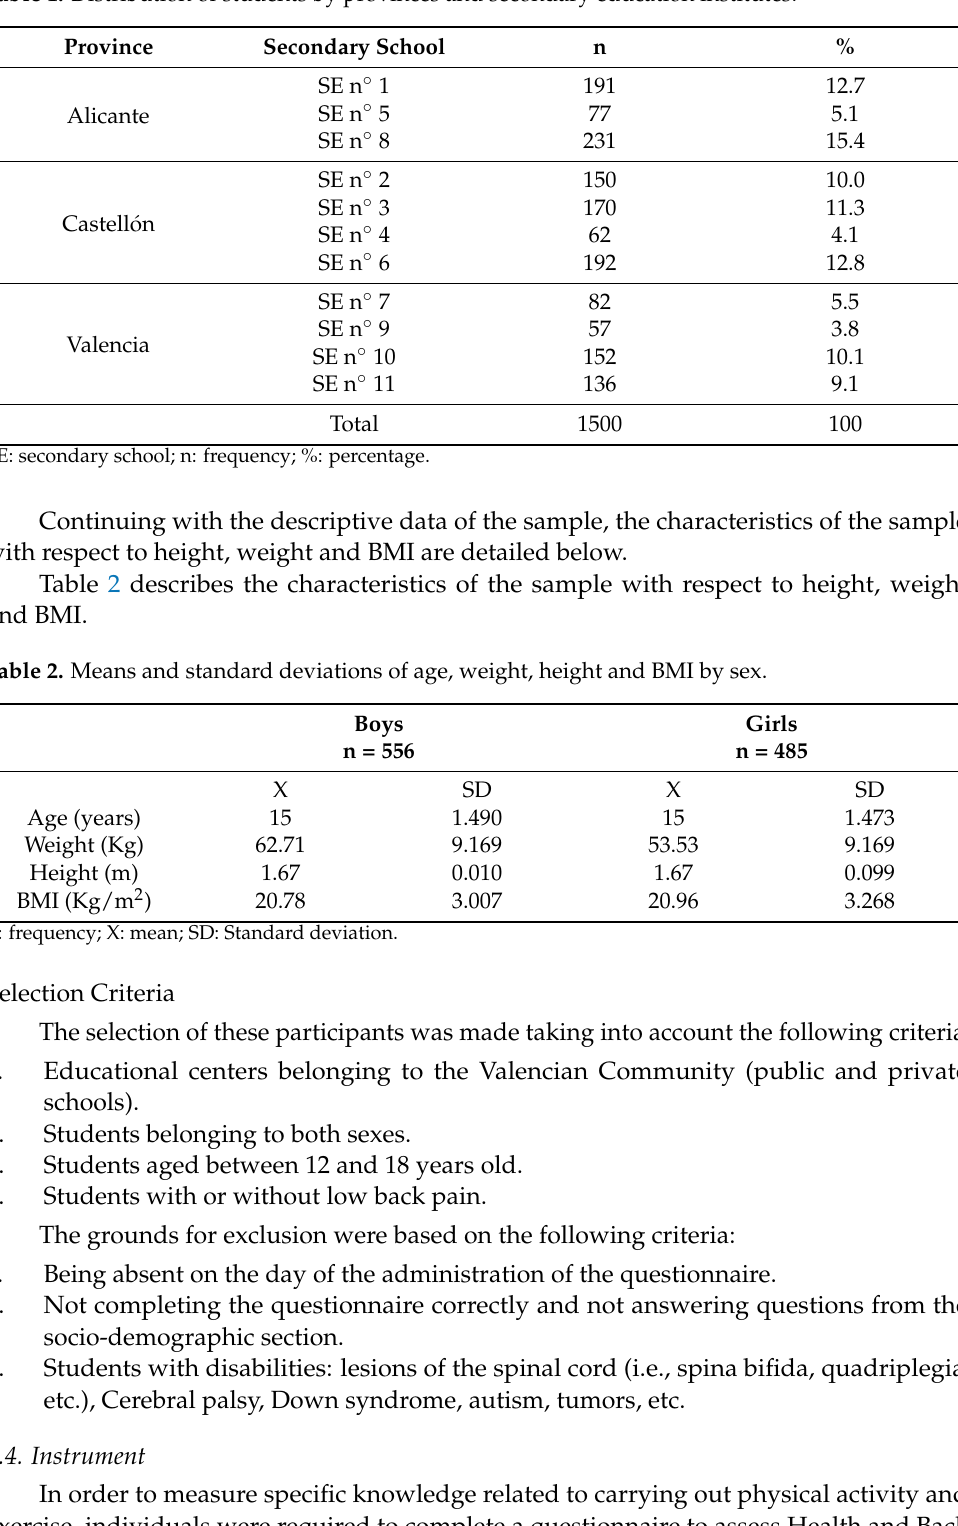
Table 1. Distribution of students by provinces and secondary education institutes.